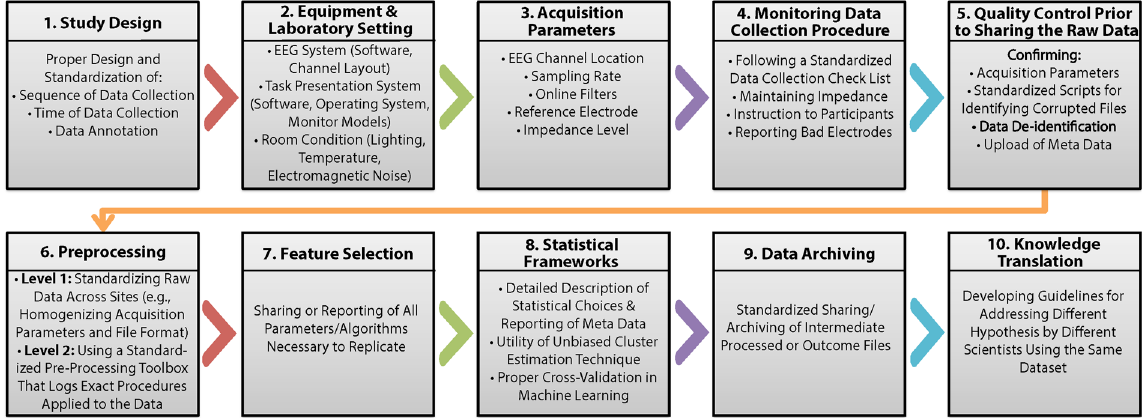
Figure 1. Potential Sources of Variance in Multi-Site EEG Studies. This flowchart summarizes the major phases of an EEG study in chronological order. For each phase, the diagram lists items/parameters/guidelines that need to be standardized in multi-site/multi-project/multi-investigator EEG